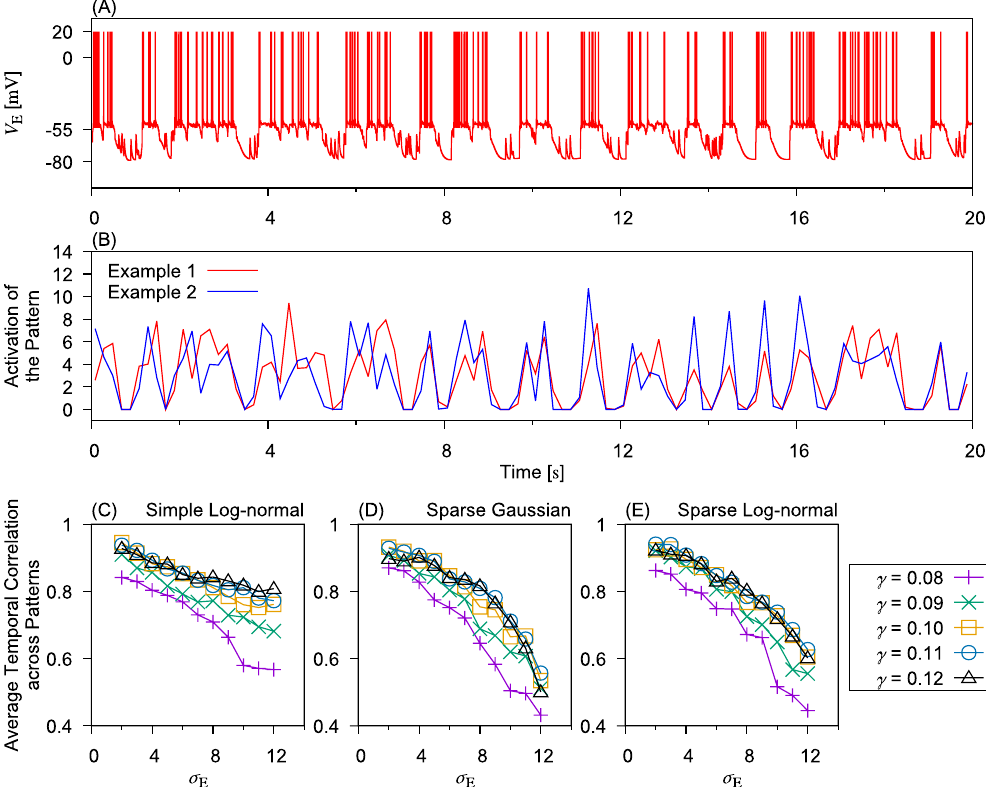
Figure 8. Relation between pattern activation correlation and σ E . ( A ) Membrane potential of an excitatory neuron is shown in a sparse-log-normal network. The parameters were set as: N E = 1000, γ = 0.12 and σ E = 12.0. ( B ) Activation trace of two example NMF-extracted patterns are presented for the simulation shown in panel (A). ( C – E ) Average correlations across NMF-extracted patterns are shown in random networks with log- normal, sparse-Gaussian and sparse-lognormal connection weights. The network size N E =